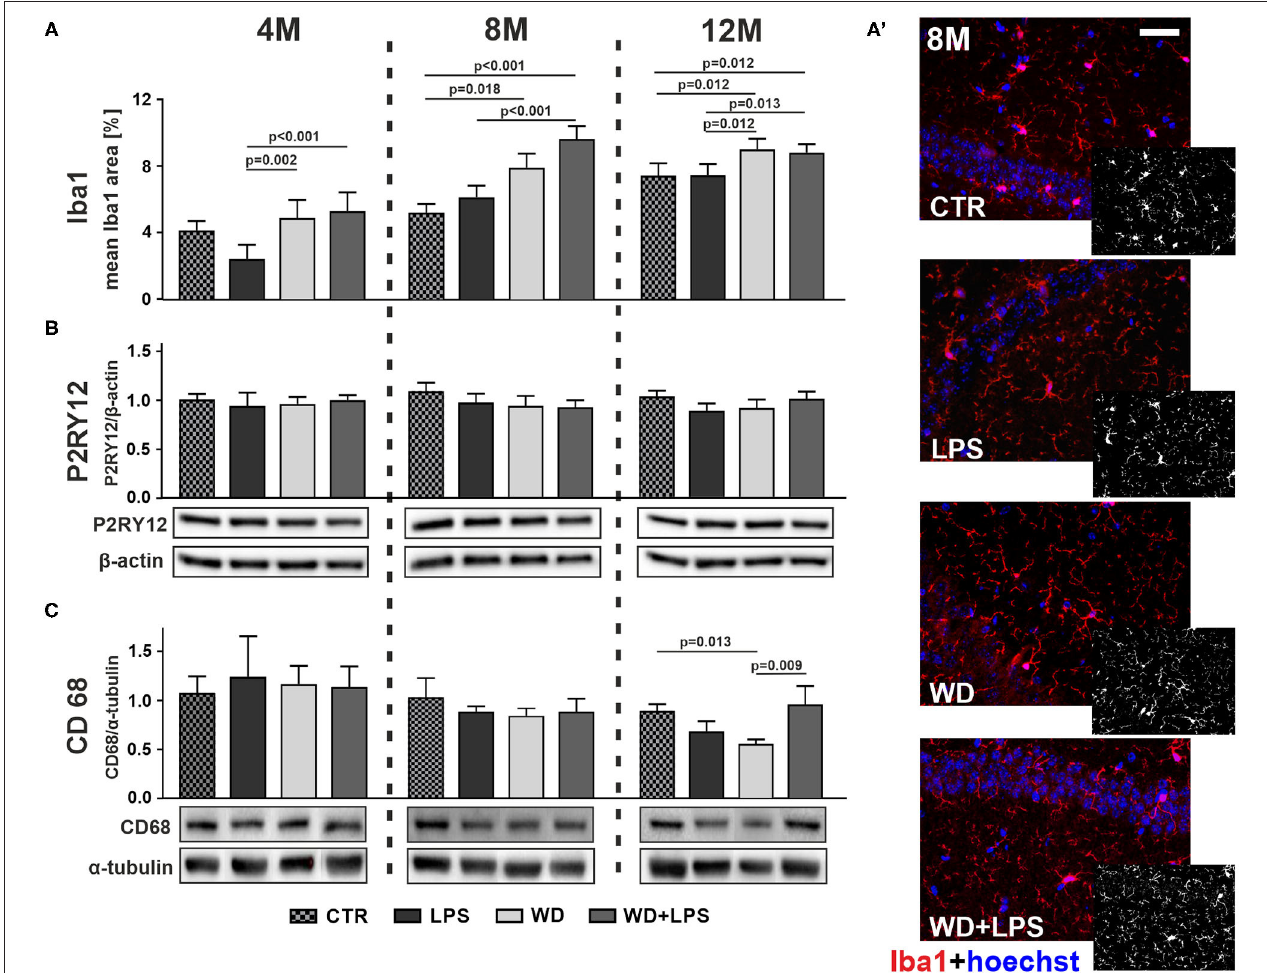
FIGURE 5 | Western diet accelerates hippocampal microglia activation and impairs their phagocytic function. (A) Graphs show mean areas of the microglia activation marker Iba1 positive staining detected in hippocampal tissue by immunofluorescence microscopy in CTR, LPS, WD, and WD + LPS groups of APPswe mice at 4-, 8-, and 12- months of age. All the data are presented as the arithmetic mean ± SD of Iba1 positive staining area from many different parts and cross-section of the hippocampi from 1 or 2 representative animals per group. The statistics were calculated using non-parametric Kruskal-Wallis test followed by Dunn’s post-test. A p -value of < 0.05 was considered a predetermined threshold for statistical significance. Graphs demonstrate that Iba1 immunostaining increased in WD and WD + LPS groups compared to both control groups and that the most significant increase was detected in 8-month-old mice. (A’) Representative immunofluorescence images of the data shown in A present the increases in Iba1 positive staining in hippocampal tissue from 8-month-old APPswe mice in WD and WD + LPS groups compared to CTR and LPS groups; the scale bar corresponds to 50 µ m; magnification: × 20; red fluorescence—Iba1, blue fluorescence—Hoechst (nuclei). Graphs show mean protein levels detected by immunoblotting of microglial anti-inflammatory homeostatic marker P2RY12 (B) and microglial phagocytic marker CD68 (C) in the mouse hippocampal tissue lysates from CTR, LPS, WD, and WD + LPS groups at the age of 4, 8, and 12 months. Below are representative immunoblots. Immunoblotting results show no differences in P2RY12 hippocampal levels among all experimental groups in 4-, 8-, and 12-month-old APPswe mice (B) , and decrease of hippocampal CD68 level in 12-month-old WD mice (C) . All the data from P2RY12 and CD68 markers are presented as arithmetic mean ± SD ( n = from 4 to 8 animals per experiment). Statistical data in (B,C) were calculated using one-way analysis of variance (ANOVA) followed by Bonferroni’s post-test or non-parametric Kruskal-Wallis test followed by Dunn’s post-test. A p -value of < 0.05 was considered a predetermined threshold for statistical